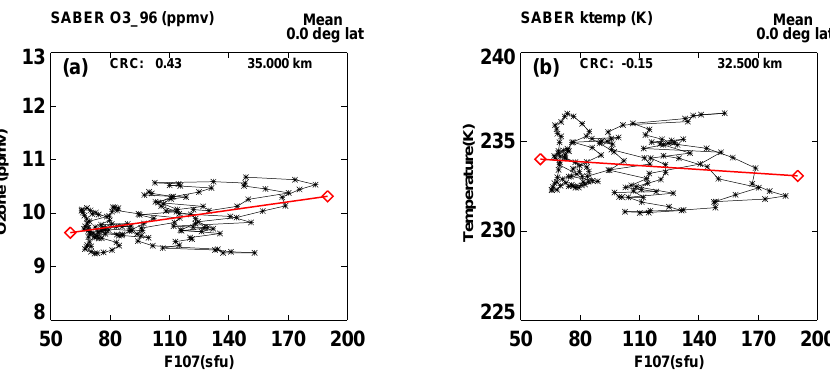
Figure 6. Left plot: scatterplot of ozone monthly values (see Fig. 1, top row) versus 10.7cm flux (sfu) at 35km and the Equator. Right plot: as in left plot but for temperature monthly